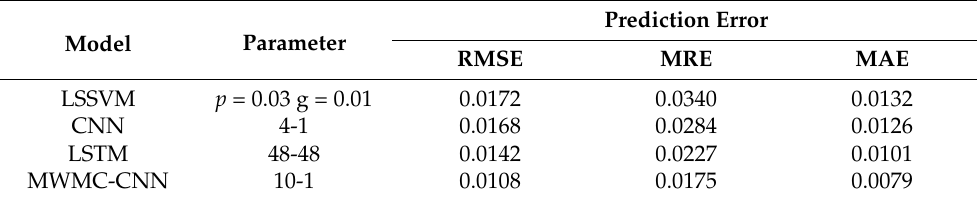
Table 1. Error comparison of different